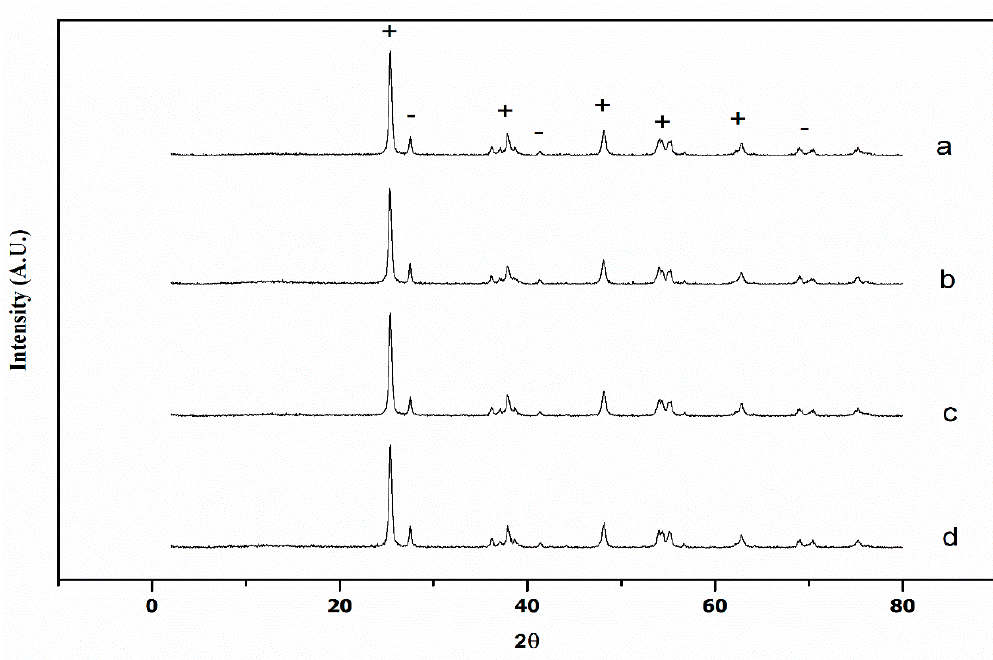
Figure 3. X-ray diffraction patterns of TiO 2 and various samples containing 0.1% of transition metal: ( a ) TiO 2 -P25, ( b ) Cu/TiO 2 , ( c ) V/TiO 2 , and ( d ) Cr/TiO 2 . +: anatase, − : rutile. The observed diffraction peaks were assigned to both anatase TiO 2 (JCPDS 89-4921), marked ‘+’,